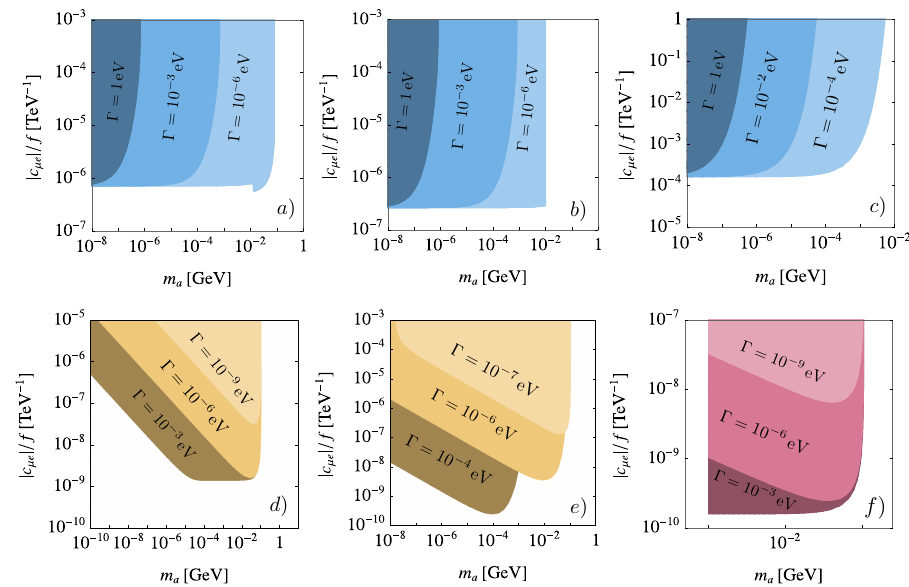
Figure 35 . Constraints on the flavor-violating ALP couplings c µe from muon decays, collected in table 2, for different values of the total ALP width. The color-coding indicates the final state: blue for invisible final states, yellow for ALP decays into photons, and red for a → e + e − decays.